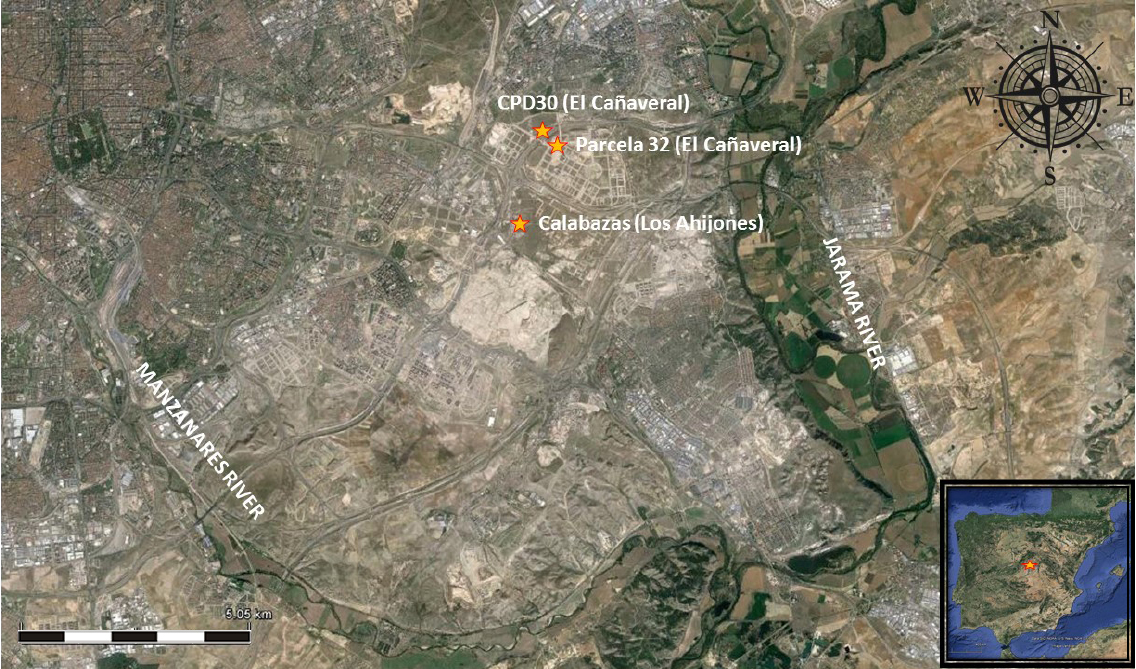
Figure 1. Middle Palaeolithic sites in the southeast Madrid. (Aerial Photography from Google Earth